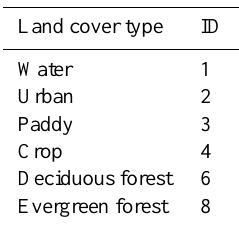
Table 2. Land cover type and its identification number (ID) in the AVNIR-2 data